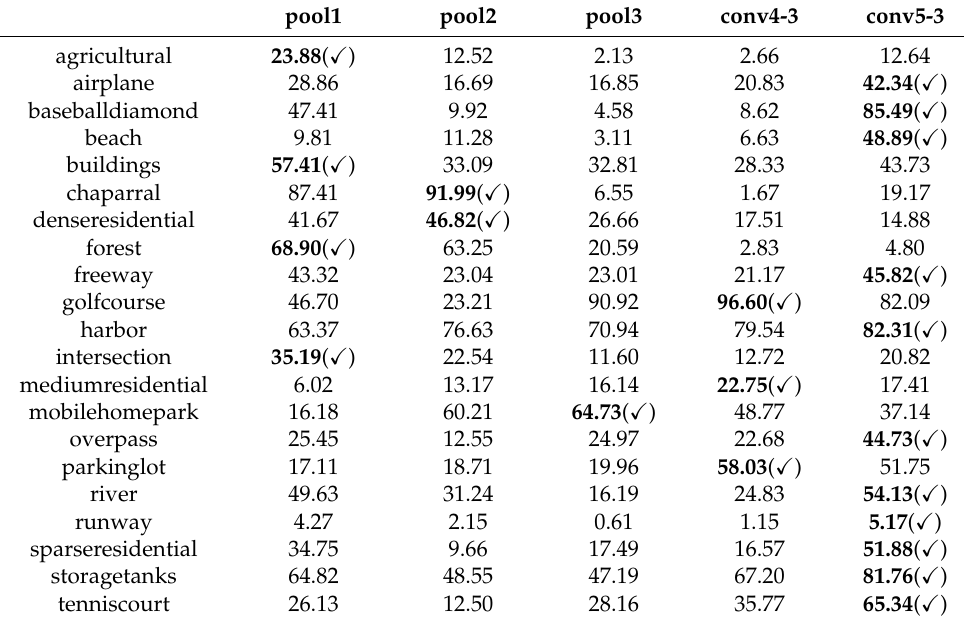
Table 1. wPO(%) of each layer from VGG-16 on